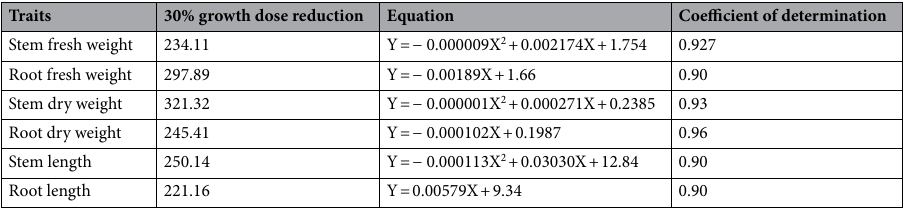
Table 2. Proper equation for 30% growth dose reduction.